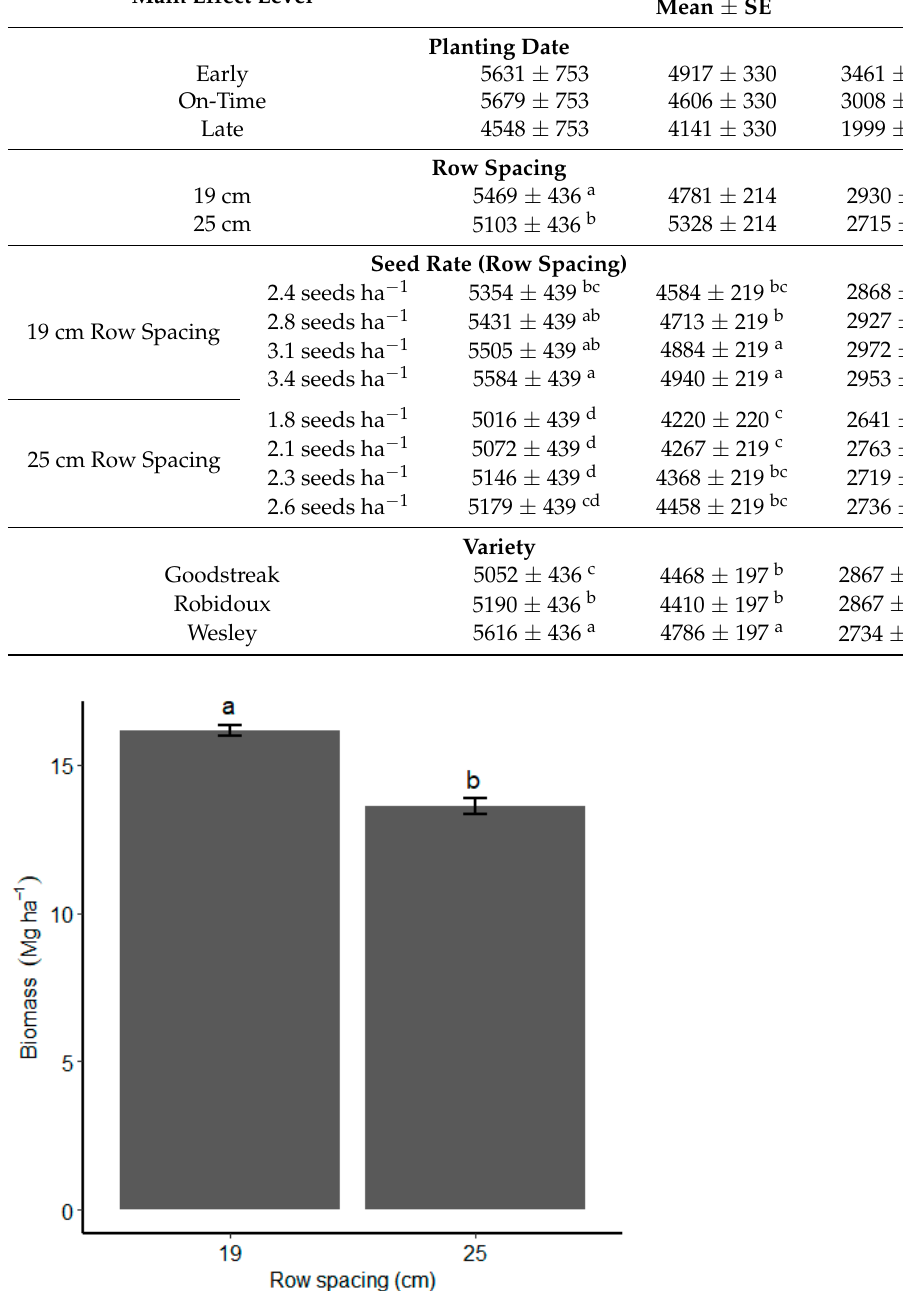
Figure 4. Effect of row spacing on the quantity of biomass produced at Hemingford. The error bar represents the standard error of the mean. Different letters on top of column bars indicate a significant mean difference at p < 0.05.